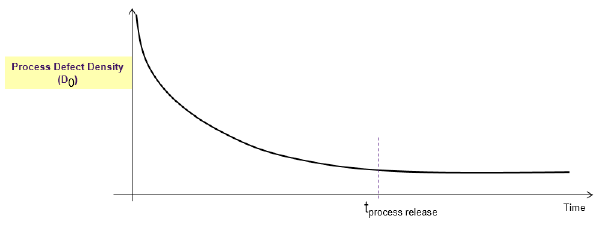
Figure 3. Graph of New Process Ramp.